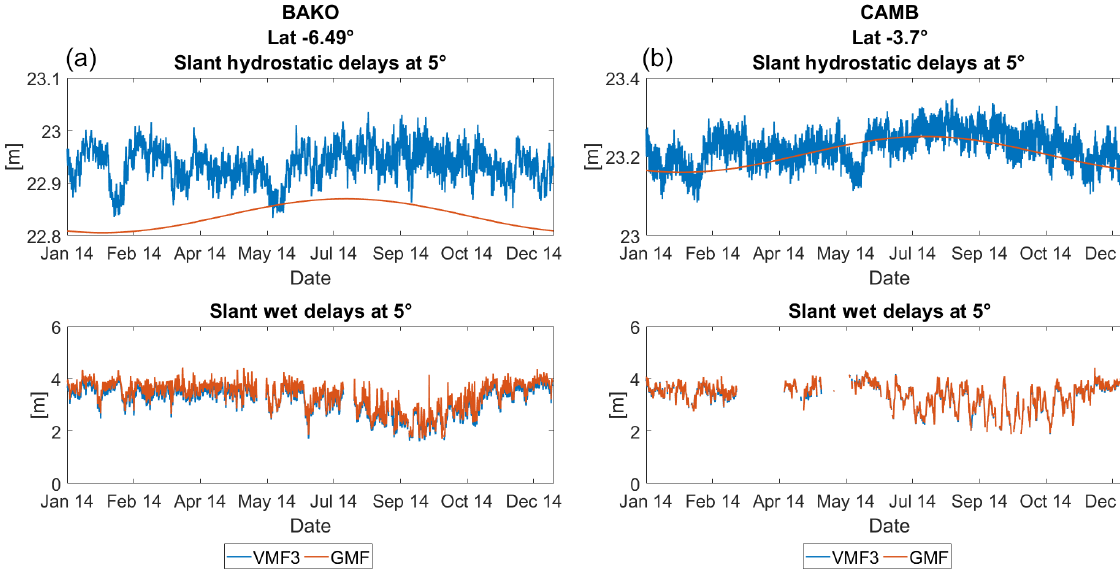
Figure 8. Slant hydrostatic and wet delays at 5 ◦ from VMF3 and GMF at sites BAKO (a) and CAMB (b) .